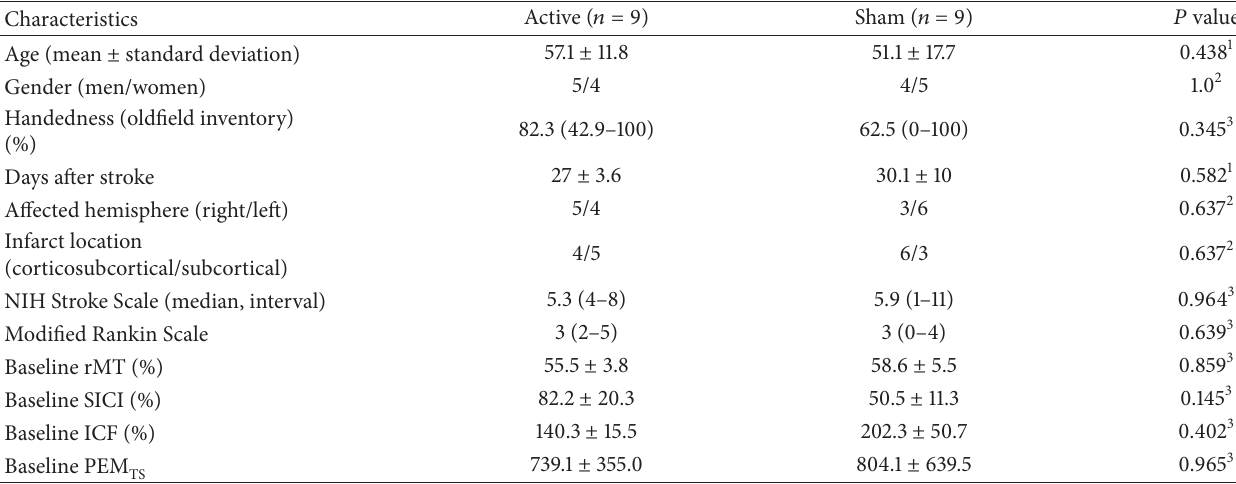
Table 1: Characteristics of the patients.